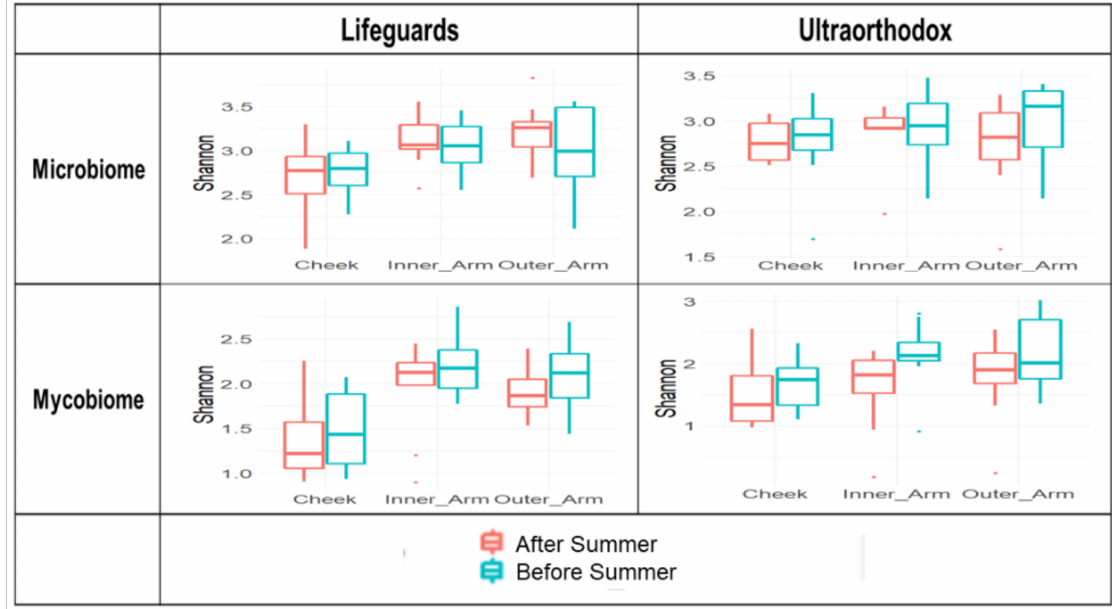
Figure 3. Alpha diversity of skin microbiome across body sites and subject groups, before and after summer. Boxplots depict medians, with lower and upper bounds showing 1st and 3rd quartiles, respectively; outliers shown as